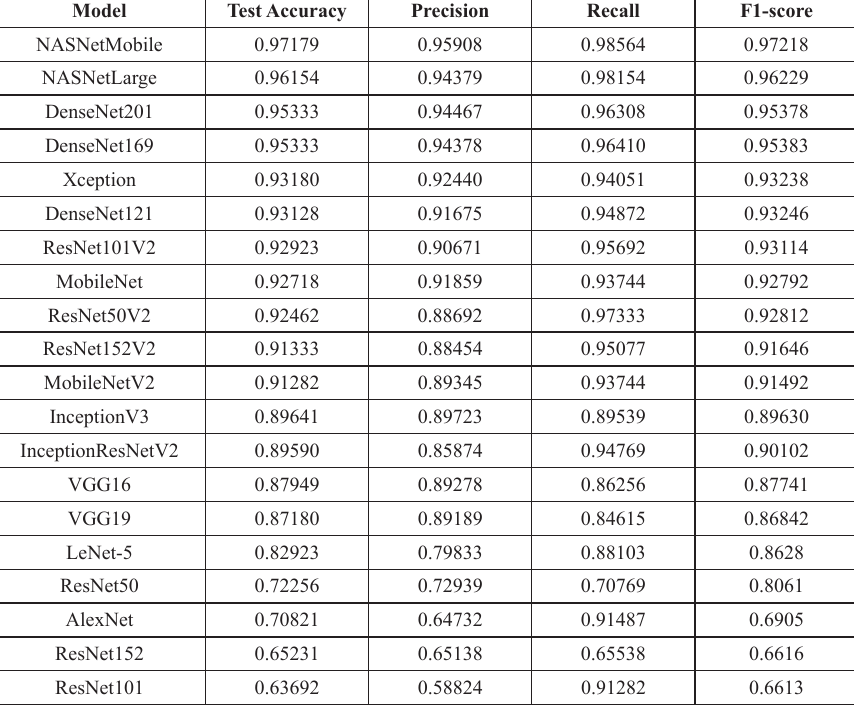
Table 4. Model’s accuracy on test set